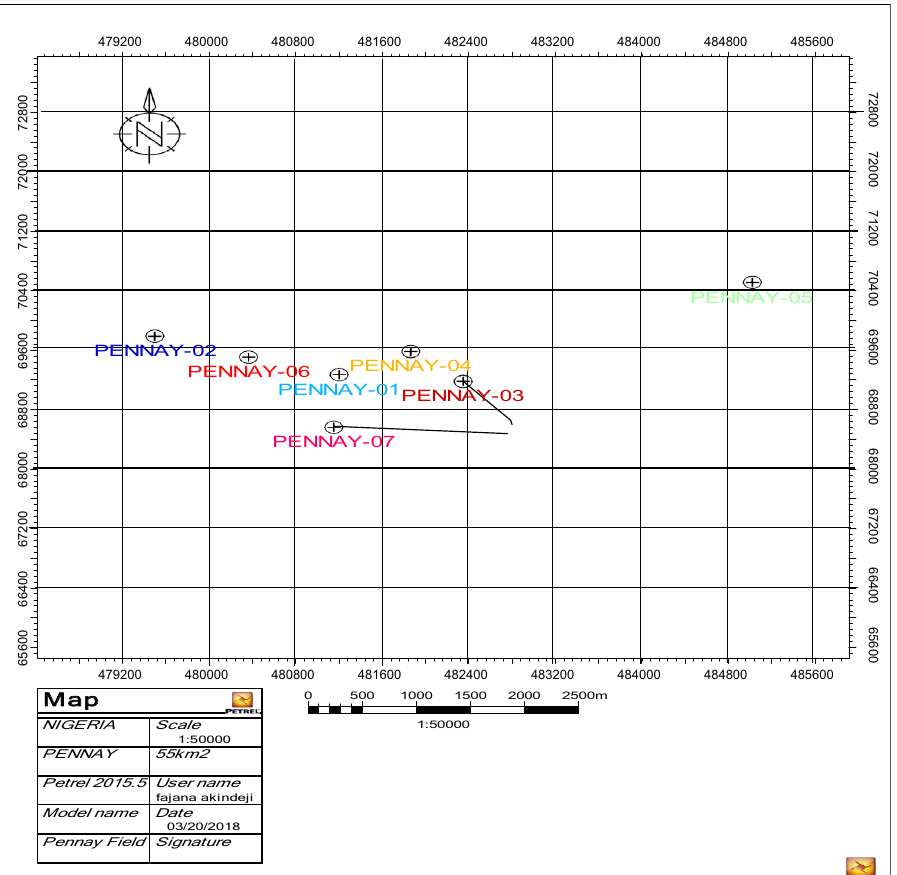
Fig. 1 Base map of the study